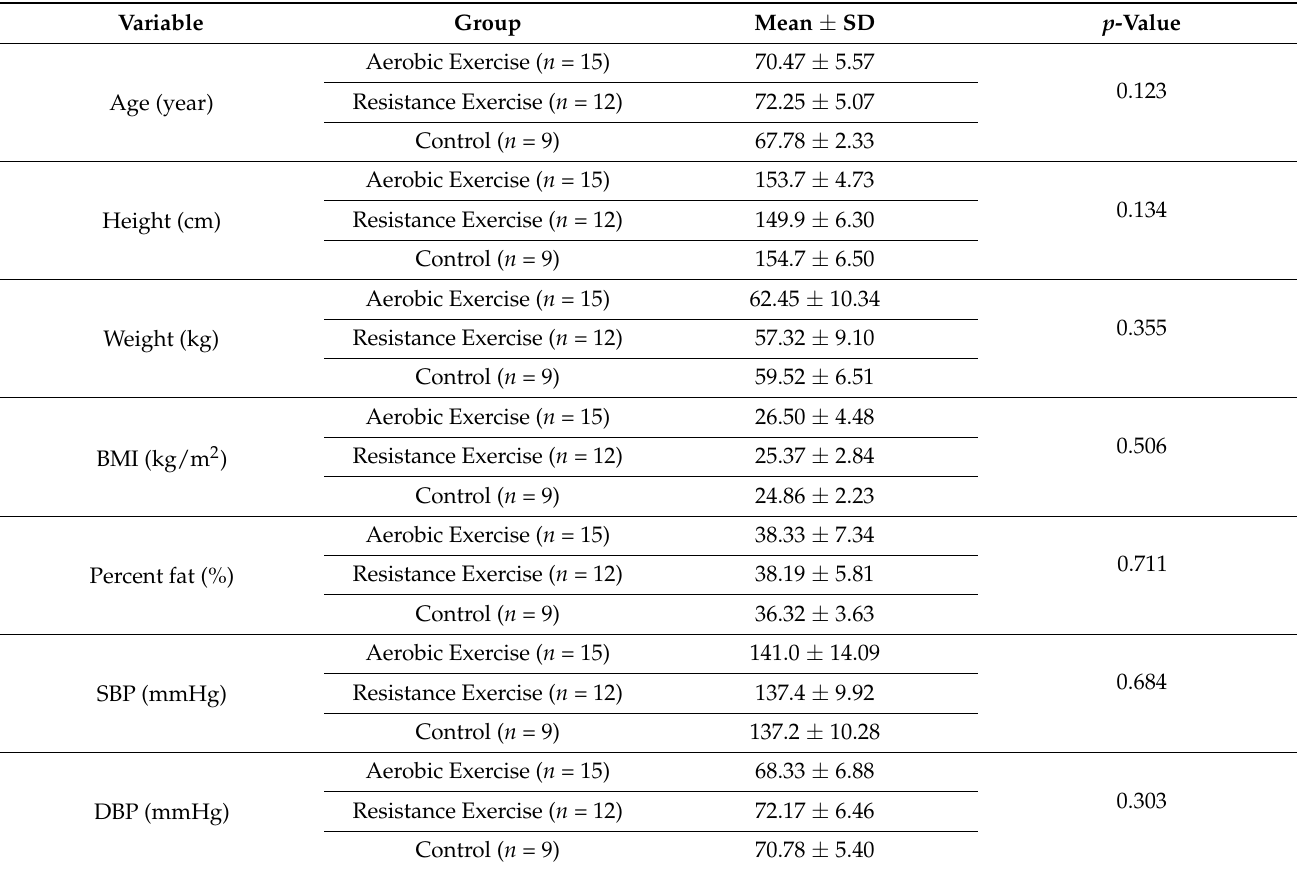
Table 1. Characteristics of the participants for